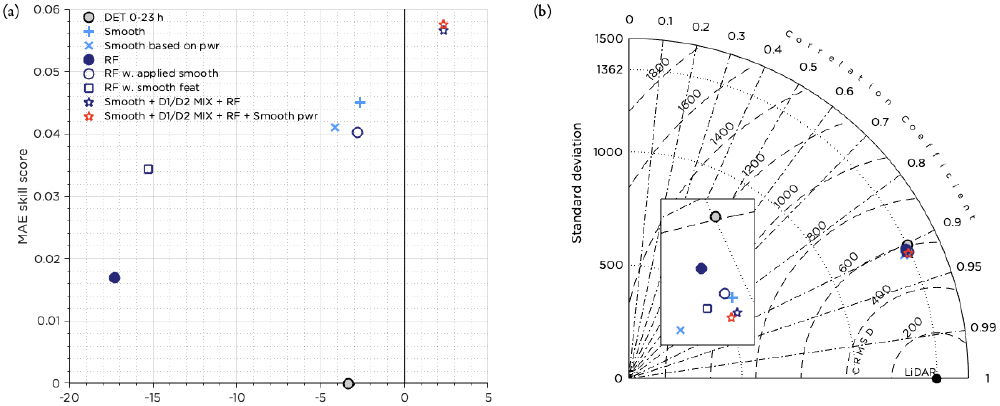
Figure 13. Performance of the RF with applied smoothing and the RF with smoothed features. Also the performance of the combined forecast using D1 / D2 MIX (during weak synoptic forcing), RF (during LLJs) and smoothing otherwise is plotted. The result of adjusting the combined forecast using smoothing based on power production for wind speeds around cut-in and the rated wind speed is also plotted. In panel (a) the MAE skill score and bias is presented and in panel (b) the Taylor diagram. To simplify comparisons, the original deterministic forecast from AROME and the results for the smoothing and RF methods presented earlier are included. The inset in panel (b) shows an enlarged portion of the figure to more clearly show the differences between the